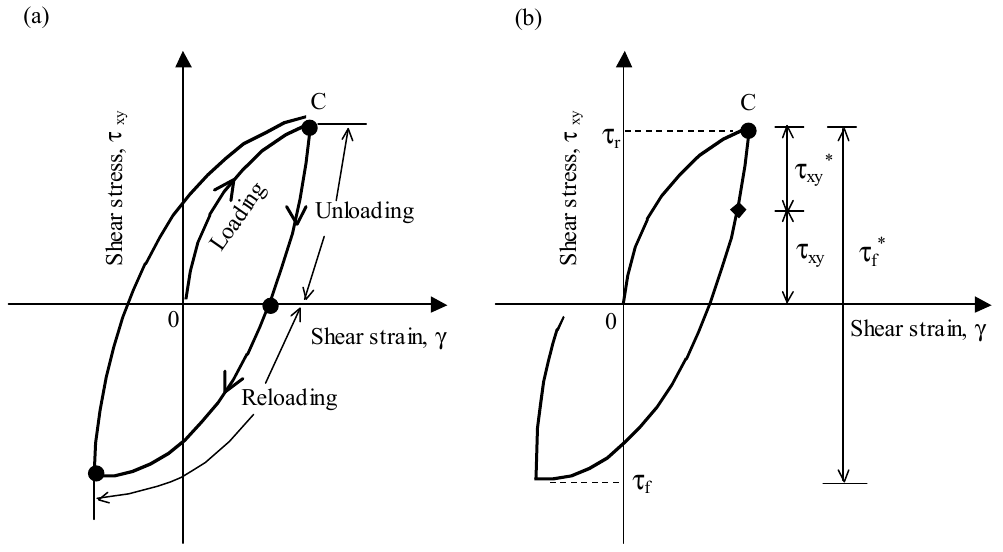
Figure 2. ( a ) Schematic of shear stress–strain relationship, and ( b ) modified shear stress during unloading and reloading.